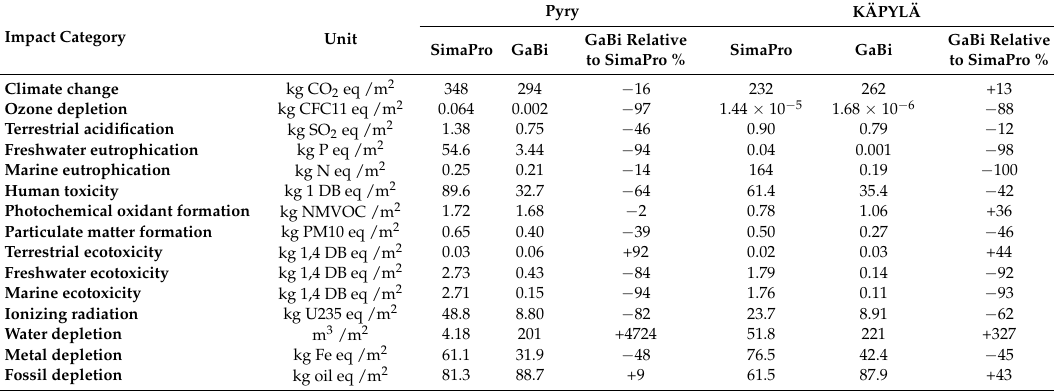
Table 3. Assessment results per square meter from GaBi and SimaPro in absolute and relative terms in the fifteen impact categories.